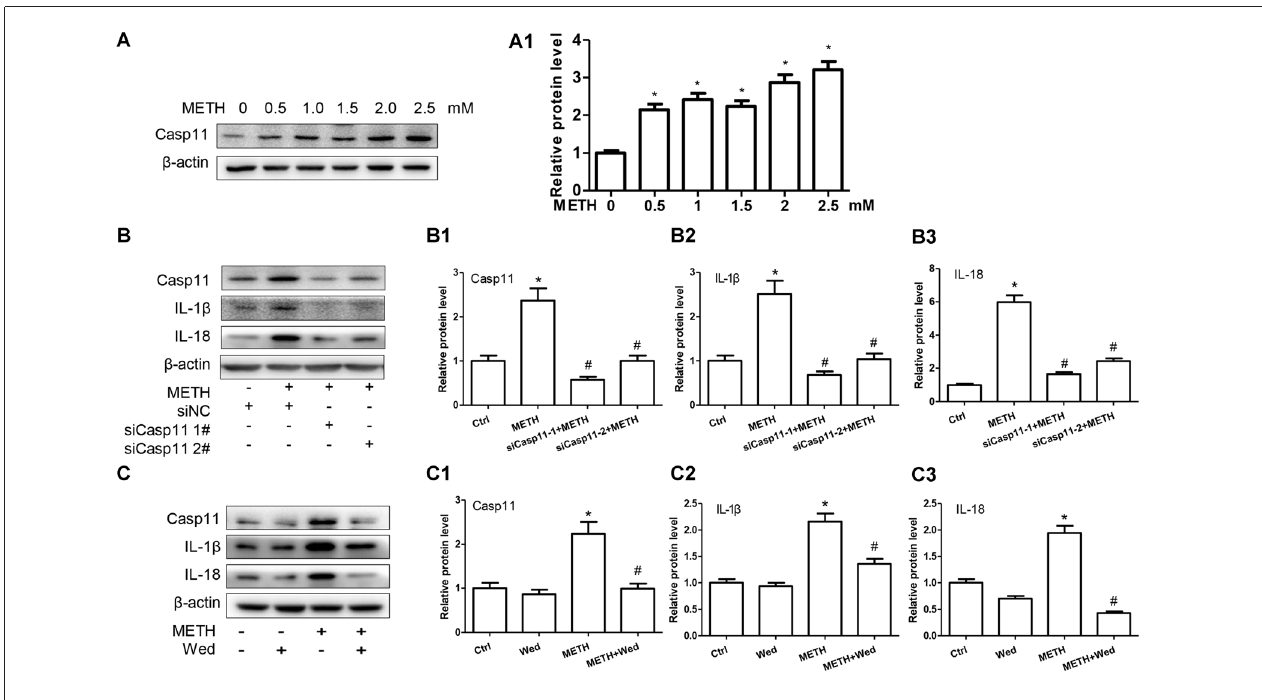
FIGURE 2 | Caspase-11 mediates IL-1 β and IL-18 expression in METH-exposed astrocytes. (A,A1) Primary cultured astrocytes were exposed to 0.5, 1.0, 1.5, 2.0 and 2.5 mM METH for 24 h. (B–B3) Primary cultured astrocytes were transfected with siRNAs targeting Caspase-11 or control siRNA for 24 h followed by METH (2 mM) treatment for 24 h. (C–C3) Primary cultured astrocytes were exposed to Wed (30 µ M) for 2 h prior to METH (2 mM) treatment as indicated. Western blot (A–C) and quantitative analyses were performed to determine Caspase-11, IL-1 β and IL-18 protein expression. All the experiments were repeated three times. Data are expressed as mean ± SD. ∗ p < 0.05 vs. non-METH-treated group. # p < 0.05 vs. the scrambled + METH treated group. Data in (A) were analyzed with one-way ANOVA followed by LSD post hoc analyses; data in (B) were analyzed with two-way ANOVA followed by LSD post hoc analyses; data in (C) was analyzed with 2 × 2 factorial ANOVA followed by LSD post hoc